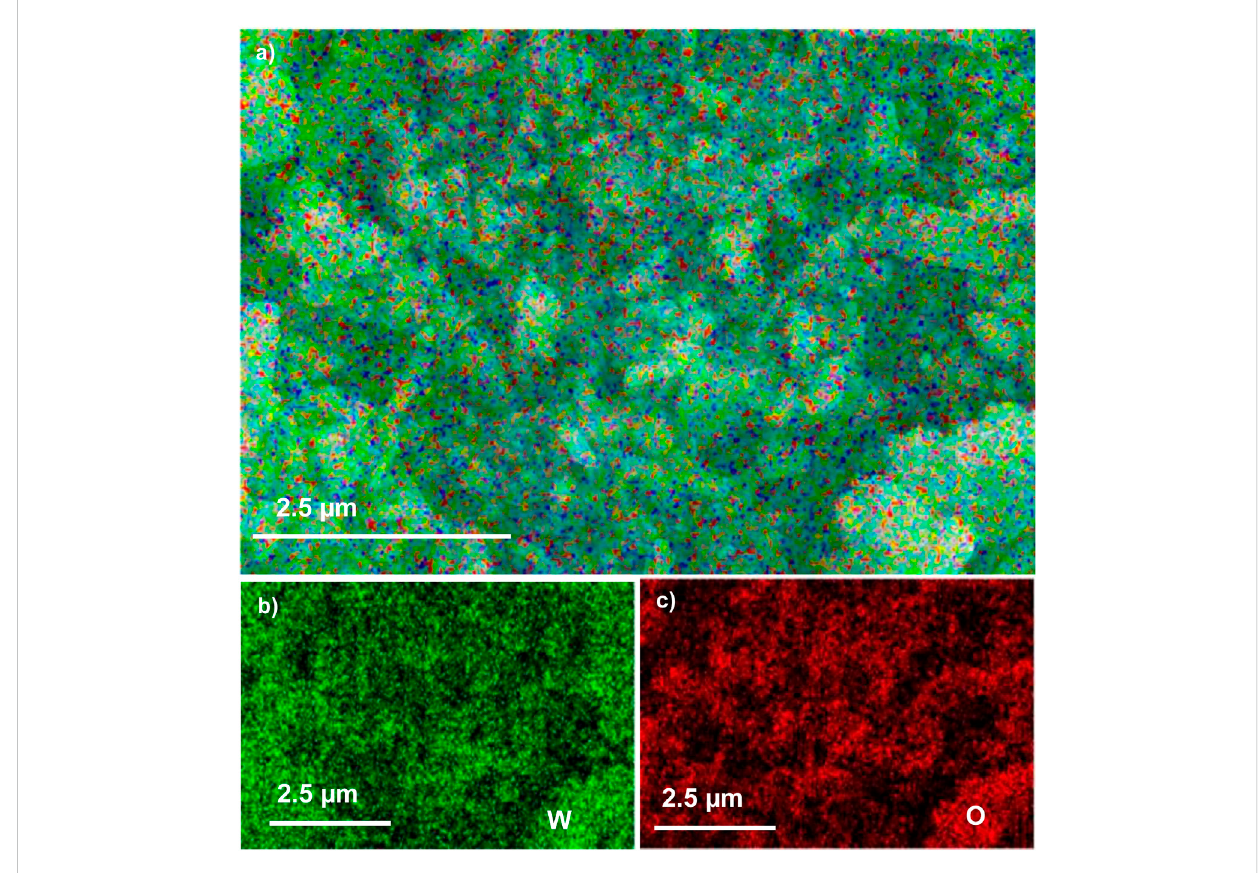
FIGURE 5 The EDX micrograph of (A) WO 3 -HCl sample, and its corresponding elements mapping of (B) W, and (C) O, based on SEM images of WO 3 -HCl.